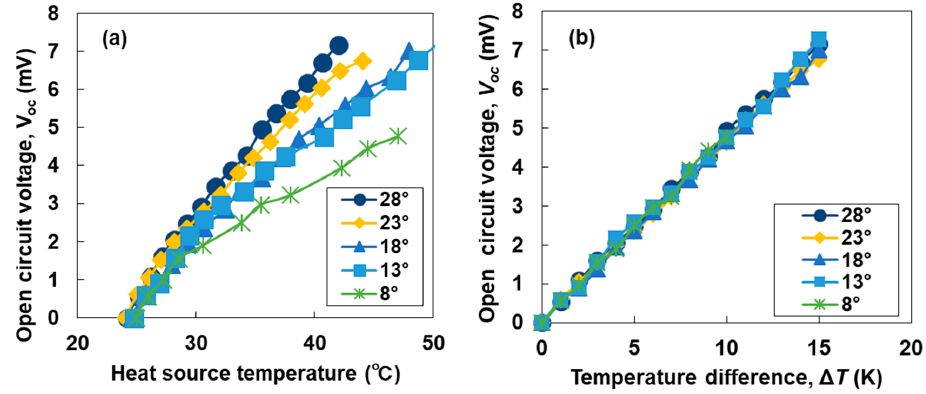
Figure 5. ( a ) Open circuit voltage ( V oc ) of slope-type thin-film thermoelectric generators as a function of heat source temperature and the ( b ) V oc of the generators as a function of temperature difference ( ∆ T